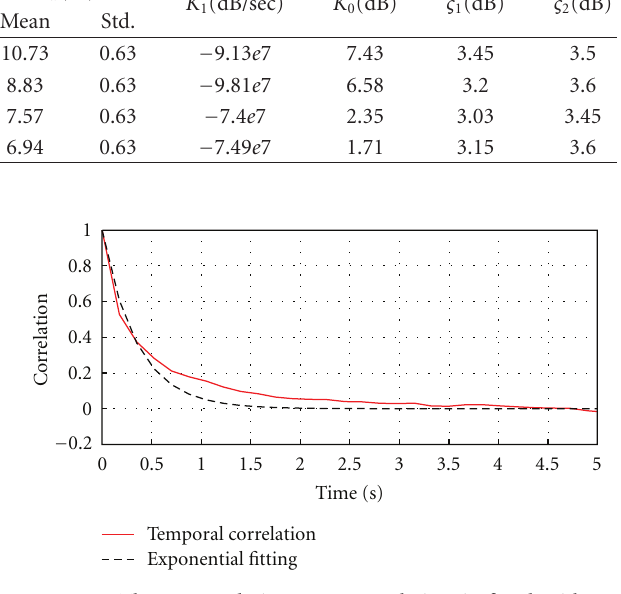
Figure 8: The averaged time auto-correlation is fitted with an exponential model.